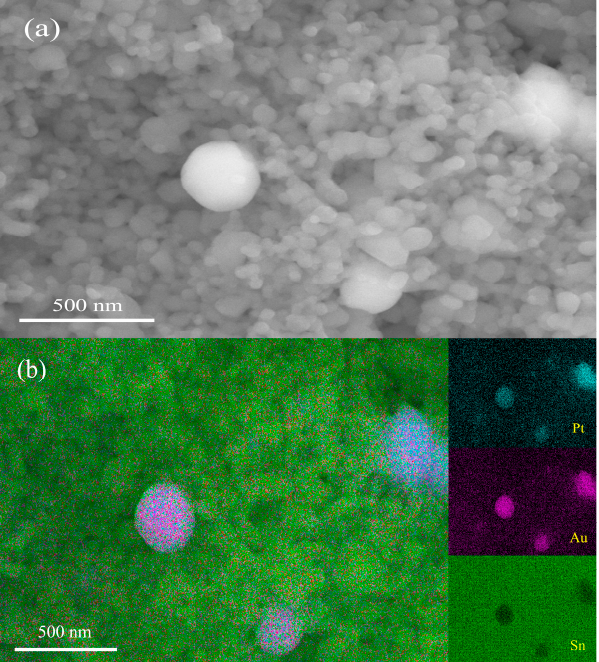
Figure 2. ( a ) SEM micrograph and ( b ) EDS analysis taken for a fractured surface of a sample of 1 wt% Pt–5 wt% Au–SnO 2 , after being sintered at 950 °C for 2 h in the air.